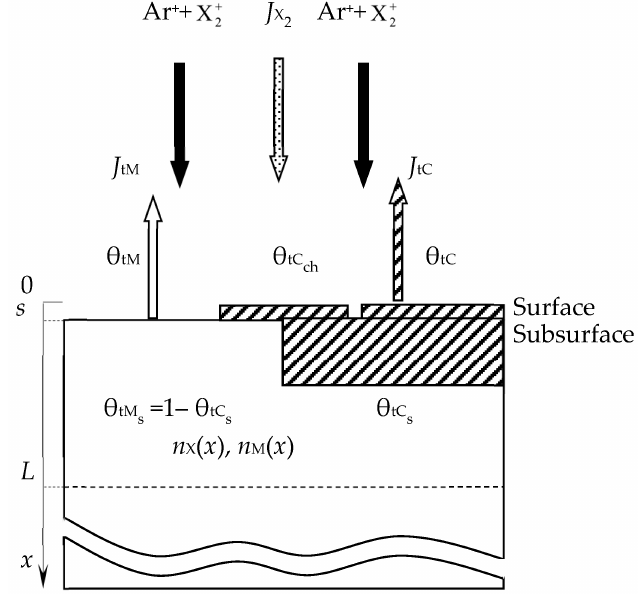
Figure 14. Model of target. Notations: J X2 is the flux density of X 2 molecules; J tM is the flux density of sputtered metal atoms; J tC is the flux density of sputtered M m X n molecules; θ tM is the fraction of the surface free from the film of the M m X n compound; θ tC is the fraction of the surface occupied by the M m X n compound formed due to the bulk chemical reaction with the participation of implanted X atoms; θ tCch is the fraction of the surface occupied by the M m X n compound formed due to chemisorption of X atoms; θ tCs is the fraction of the subsurface region in the s plane occupied by the M m X n compound formed due to the bulk chemical reaction m M + n X ↔ M m X n ; θ tMs = 1 − θ tCs is the fraction of the subsurface region occupied by free M metal atoms; n X ( x ), n M ( x ) is the volume concentration of free X and M atoms, respectively, which did not take part in the chemical reaction.